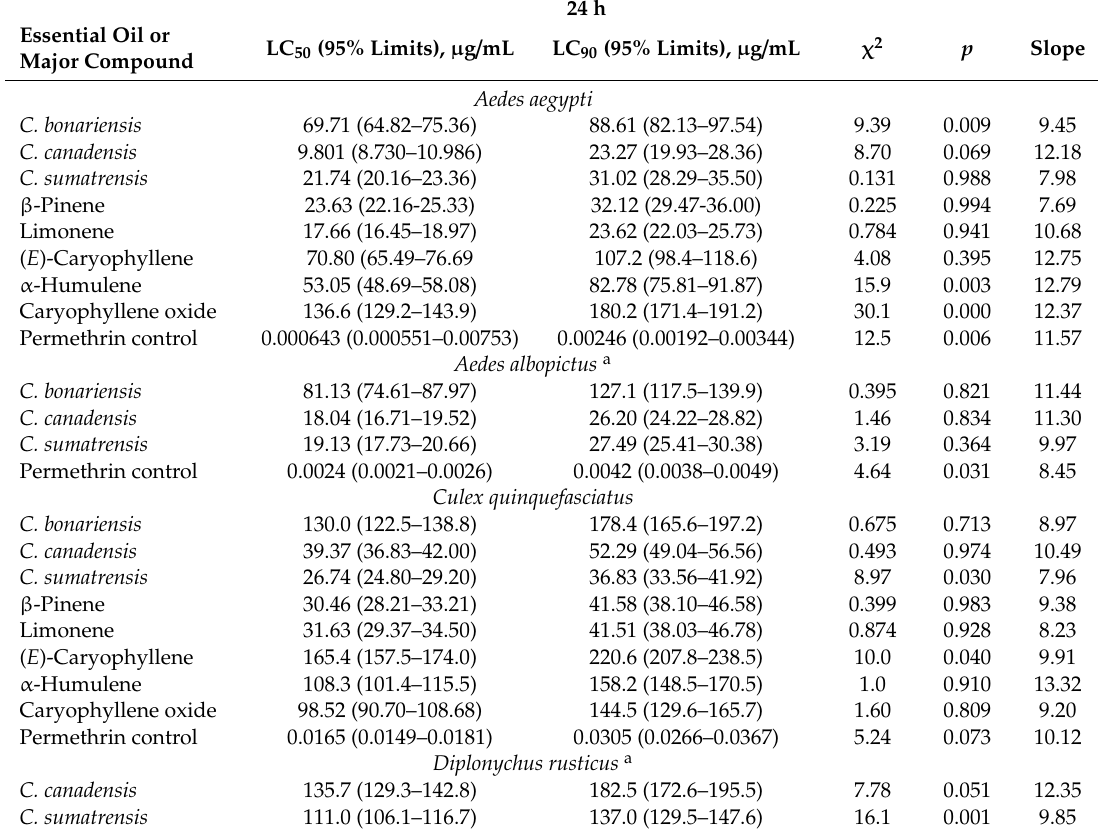
Table 3. Mosquito larvicidal activity and insecticidal activity of Conyza essential